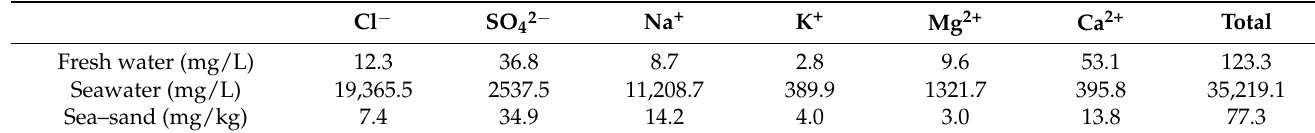
Table 2. Comparison in chemical composition among the fresh water, seawater, and sea–sand.